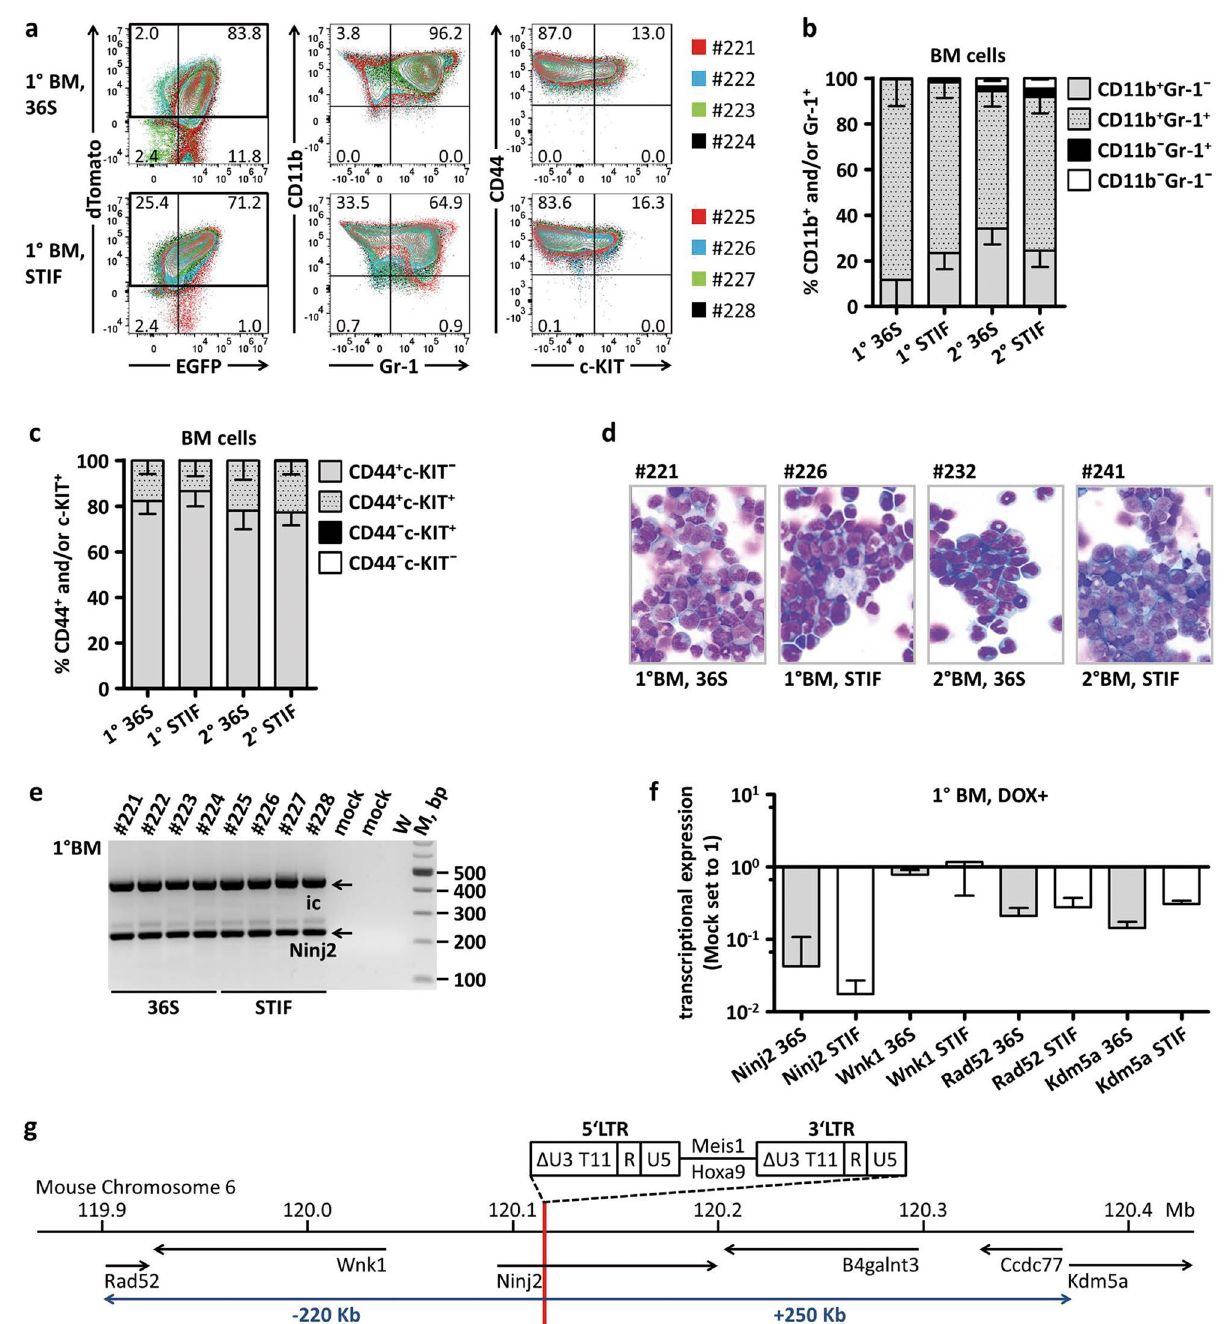
Figure 5. Immunophenotype, morphology and insertional analysis of doxycycline-dependent H9M-ciMP induced AMLs. ( a ) Strategy of bone marrow (BM) immunophenotype analysis of doxycycline-treated primary (1°) recipients transplanted with H9M-ciMPs cultured under myelomonocytic (36S) or stem cell maintaining (STIF) conditions. Flow cytometry plot overlays to present expression of CD11b/Gr-1 and CD44/c-KIT in the EGFP + dTomato + and EGFP − dTomato + cells. Frequency percentages are given for recipients #224 (36S) and #228 (STIF). ( b–c ) Histogram presentation of percentages of CD11b + and/or Gr-1 + ( b ) and CD44 + and/or c-KIT + ( c ) positive cells in gated EGFP + dTomato + and EGFP − dTomato + cells from BM of 1° and secondary (2°) 36S and STIF recipients. Data are represented as mean ± SD for animals in each group, n = 4. ( d ) Cytospin analysis (May-Grünwald/Giemsa staining, magnification × 60) of BM cells from selected 1° and 2° 36S and STIF recipients. ( e ) Ligation-mediated PCR analysis demonstrating insertion sites in BM cells of 1° 36S and STIF recipients. W, water; M, 100 bp marker; bp, base pairs; ic, internal control; mock, BM cells from non-transplanted doxycycline-treated mice. ( f ) Histogram presentation of transcriptional expression for genes located in the Ninj2 locus in BM cells of 1° 36S and STIF recipients. The expression level of the control non-transplanted DOX-treated murine cells (Mock) was set to 1. Data are represented as mean ± SD, n = 4 (for Ninj2 ), n = 3 (for other genes). ( g ) Genes located within ± 250 kb from retroviral insertion in the Ninj2 locus. Scale based on the Ensembl database, release 98—August 2020. H9M-ciMPs, conditionally immortalised myeloid progenitor cell lines engineered to co-express Hoxa9 and Meis1 ; AML, acute myeloid